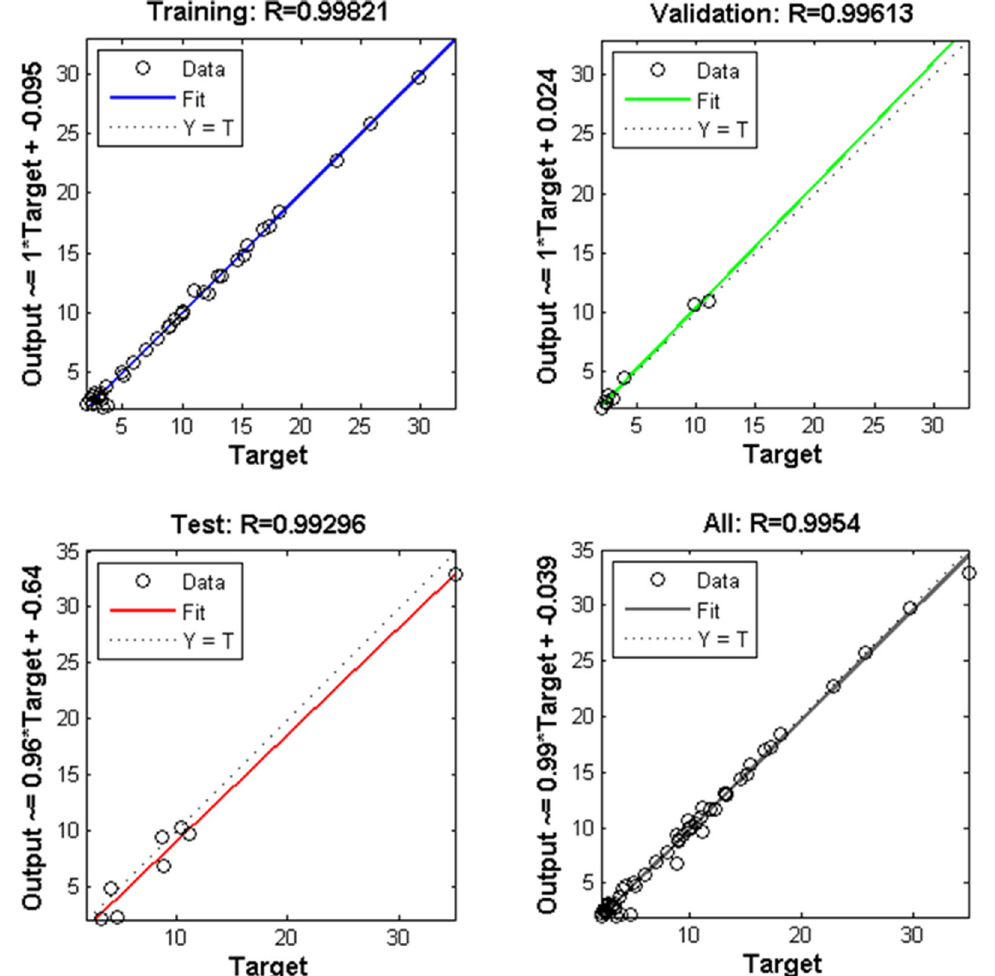
Fig. 2 Trained network for CH 4 selectivity